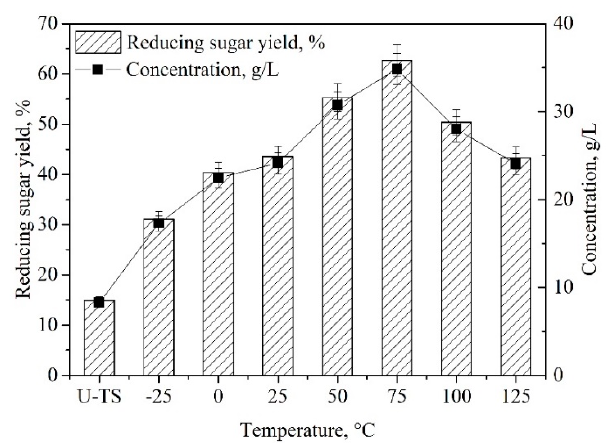
Figure 3. Effects of TS pretreatment temperature on the enzymatic saccharification of TS. [Pretreat- ment condition: NaOH (7 wt%)–ChCl:UA-TA (8 wt%), − 25 − 75 °C, 60 min; Enzymatic hydrolysis condition: cellulase (10.0 FPU/g TS) and xylanase (30.0 CBU/g TS), 50 o C, pH 4.8]. [U-TS represents untreated TS].